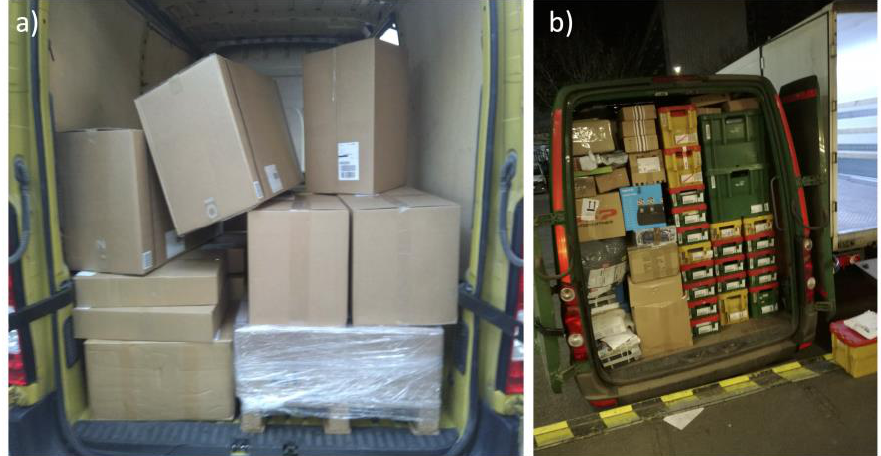
Figure 1. Stacked parcels during daily express delivery service, ( a ) mid-sized packages ( b ) small packages.